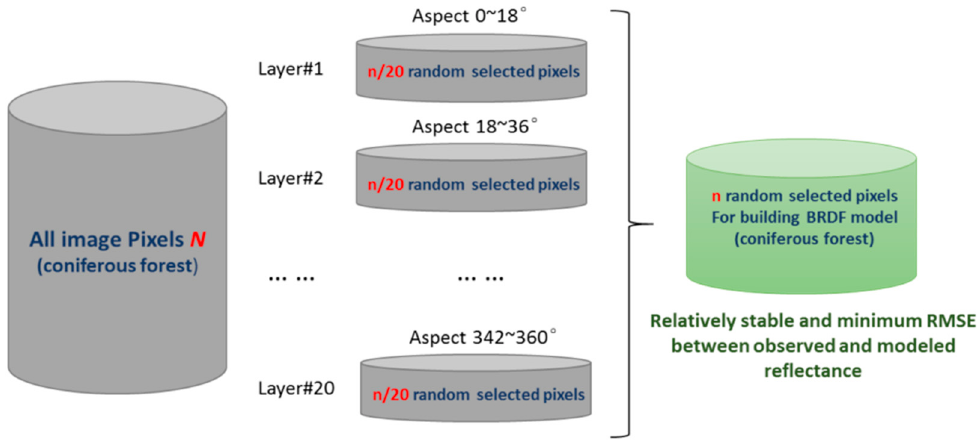
Figure 3. Flowchart of the stratified random sampling method for coniferous forest pixel selection.